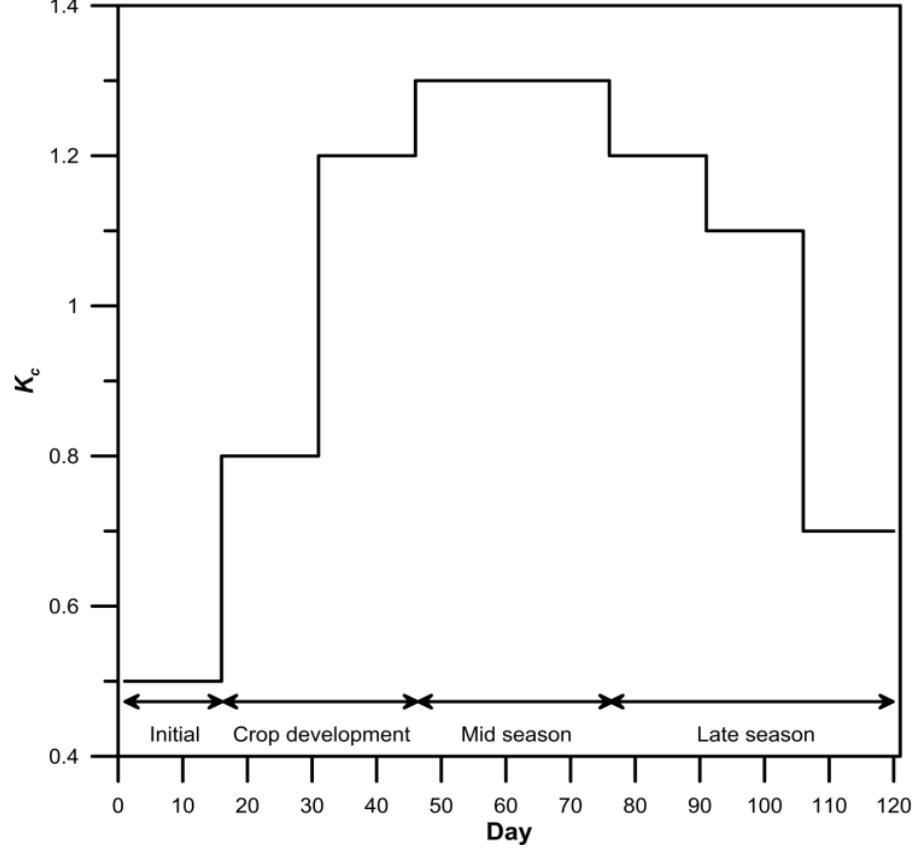
Figure 3. Crop coefficient ( K c ) of paddy at each day during cropping